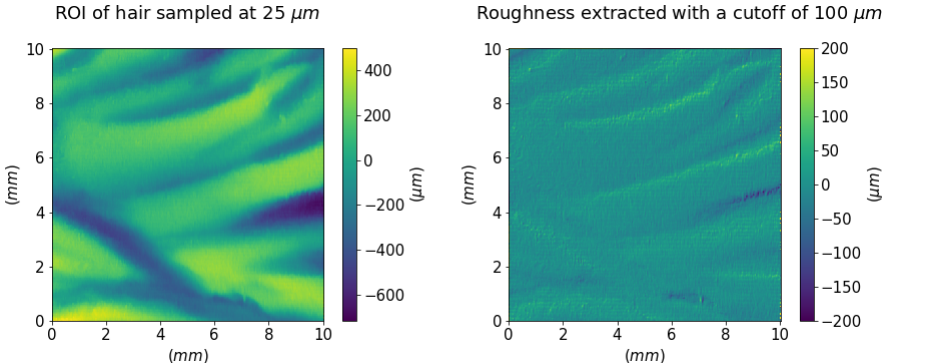
Figure 13. Height map of a portion of Christ’s hair sampled at 25µm and its finer surface texture. 3.3. Tactile Exploration of Painted Figures for Visually Impaired People: Apulian Red-Figure